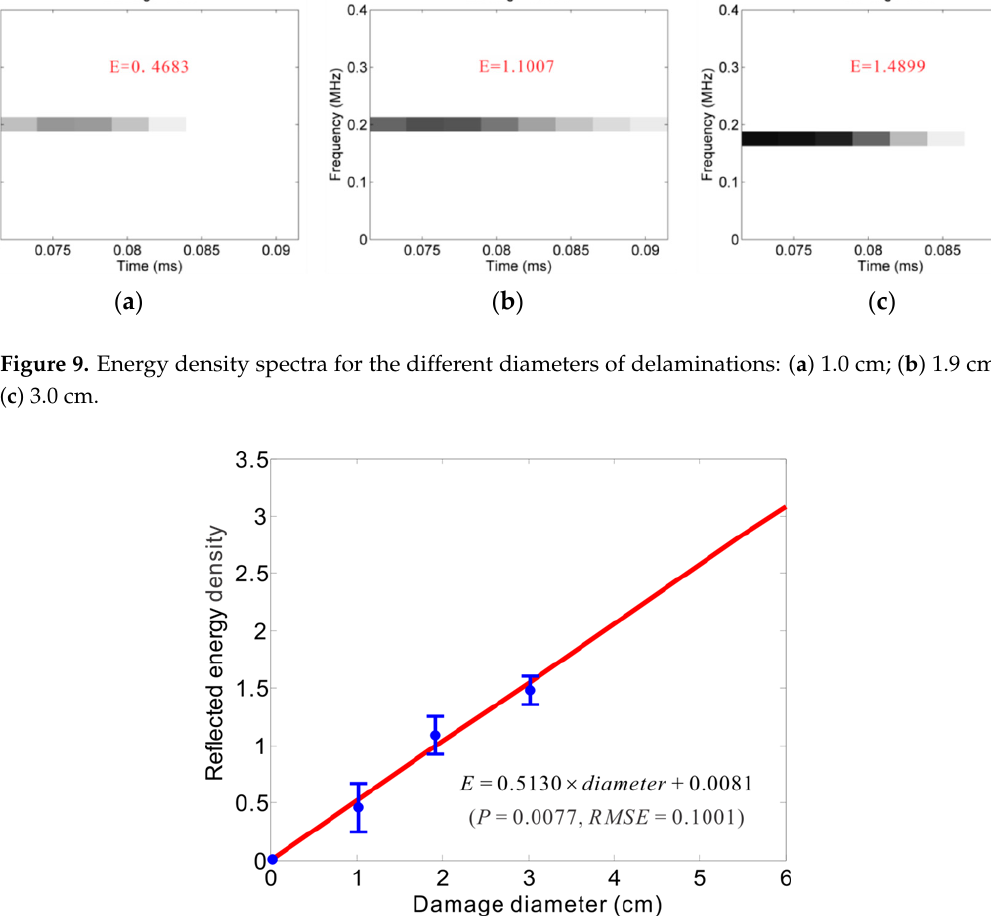
( b ) Figure 8. Energy density spectra for damage identification. ( a ) Non-damage condition; ( b ) A damaged condition—delamination presence.